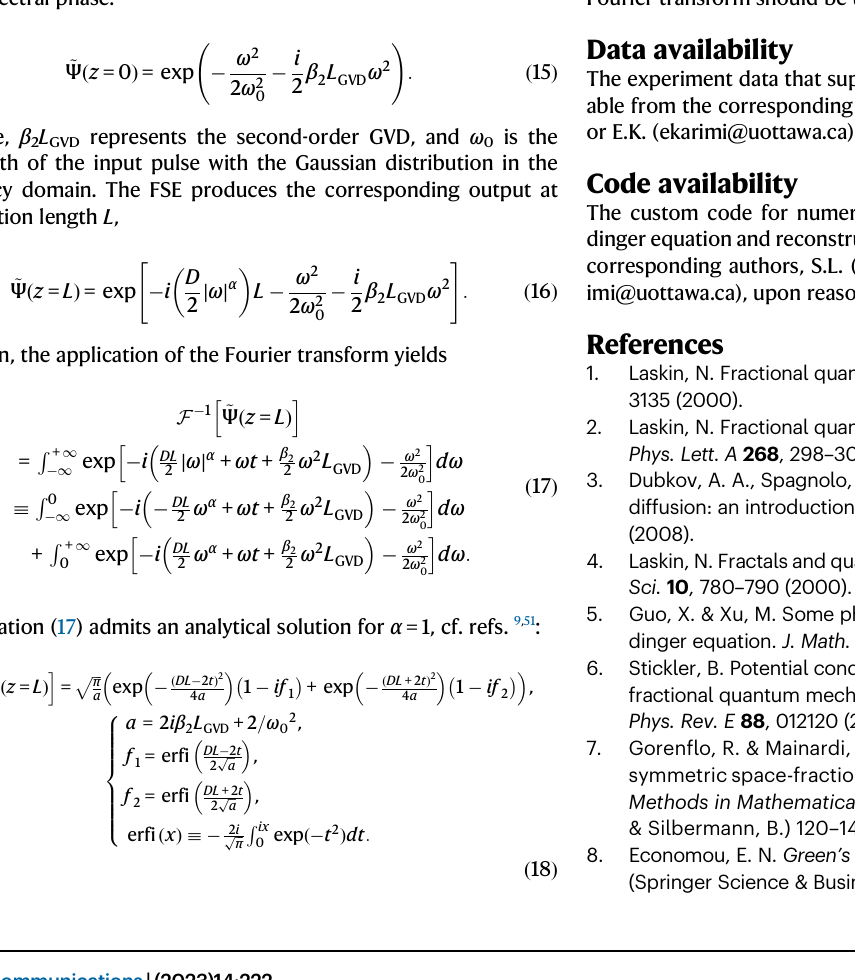
mentoftheamplitudeandphase.ThecollinearFROGsystemisusedto determine the initial amplitude and phase of the two pulses and to calibrate the SSI. The collinear FROG system deals with pulse duration 317 and 348 fs for the reference and signal pulses, respectively. The bandwidth of these pulses is 6.59 and 4.84 nm, respectively. These measurements are necessary for the calibration of SSI. For the pulse- shapersystem,themeasuredfrequency resolutionintheFourierplane ofthe4 f setup(ontheSLMsurface)is ≃ 1.88 nm/mm,andthetemporal window is ≃ 8 ps. More details concerning each section of the setup can be found in Supplementary Notes 1 – 3.